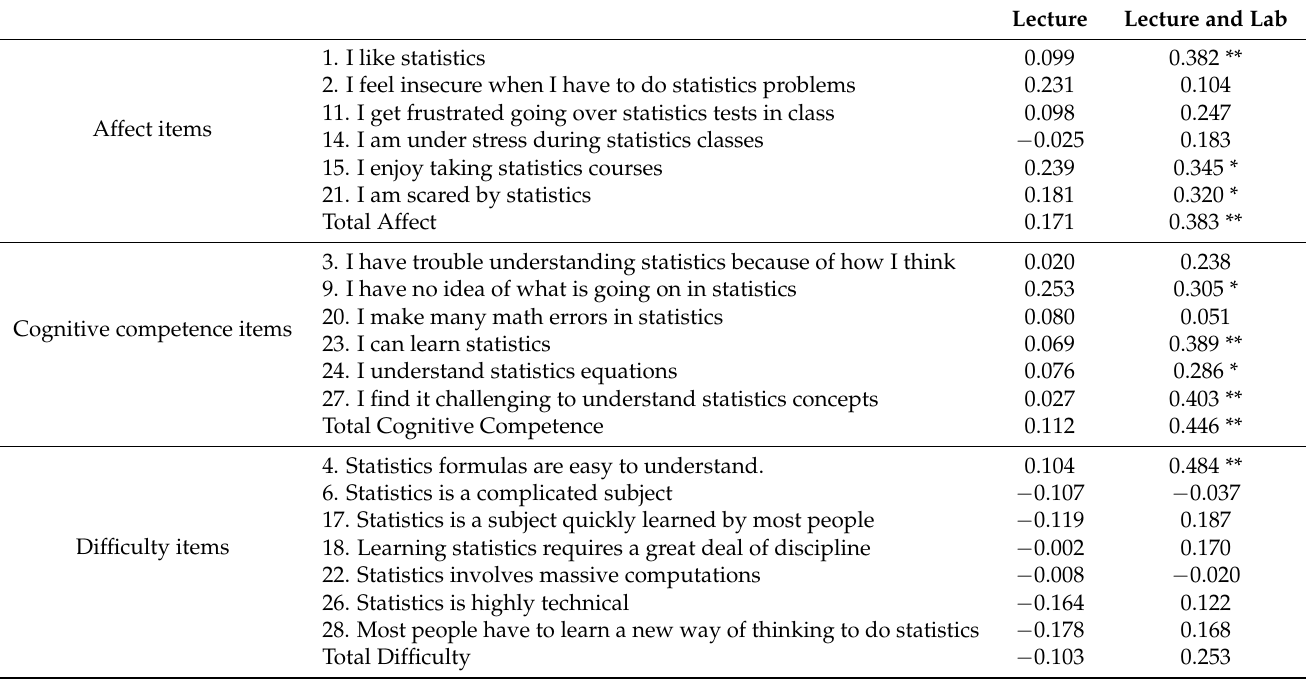
Table 2. Product–moment correlation coefficients; variables of interest with SDR in the two